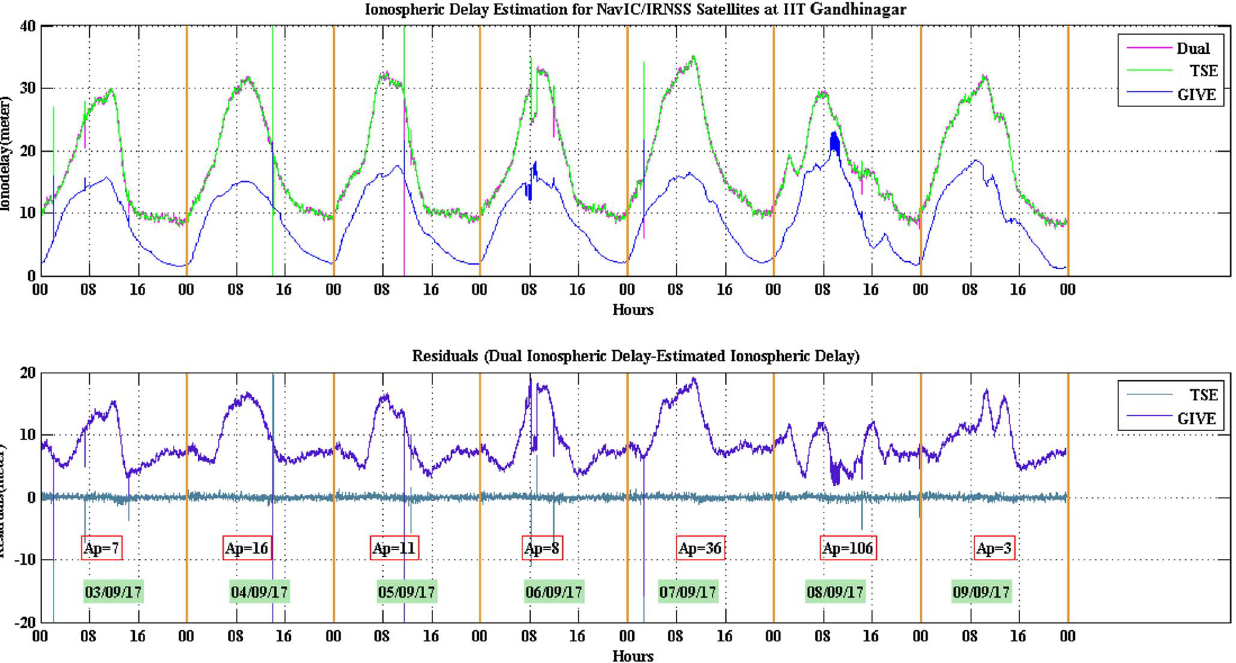
Fig. 7. The average ionodelay performance comparisons of TSE, dual frequency and GIVE model for NavIC/IRNSS satellites at the IIT Gandhinagar on the observation duration (3 – 9 September